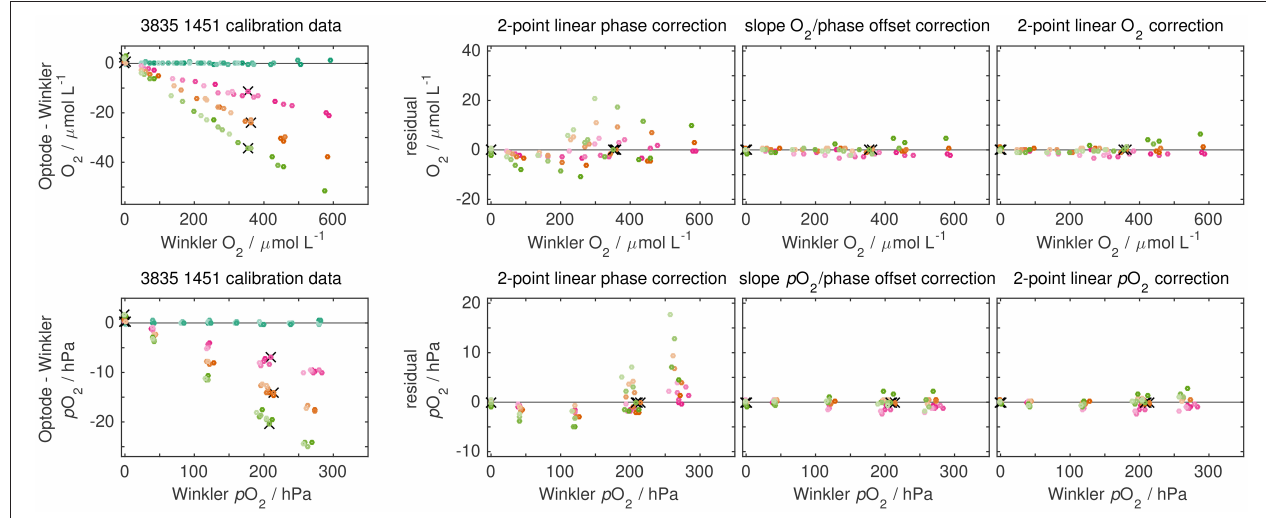
FIGURE 6 | Character of drift (left) and comparison of correction approaches by 2-point correction (right set of panels) for a subset of calibrations of optode 3835 1451 (CSIRO-O&A, Hobart). The timing between calibrations is shown in Figure 7 with the same color code. Lighter colors indicate calibration points at lower temperatures. Upper and lower panels show the same data but either expressed as O 2 concentration or O 2 partial pressure. The first calibration was used to derive optode calibration coefficients that were applied to subsequent calibration data. Two-point corrections were mimicked by using just two specific calibration points of the calibration data (denoted by black crosses), whereas residuals after correction are shown for the full calibration data. Sensor drift is linear with oxygen and shows a small (positive) intercept at zero O 2 . Accordingly, corrections with a slope O 2 concentration/partial pressure term perform well, while a linear phase correction shows significant mismatch between corrected and reference data both at different O 2 and temperatures than the 2-point data. Data for all sensors are given in Figures S4,